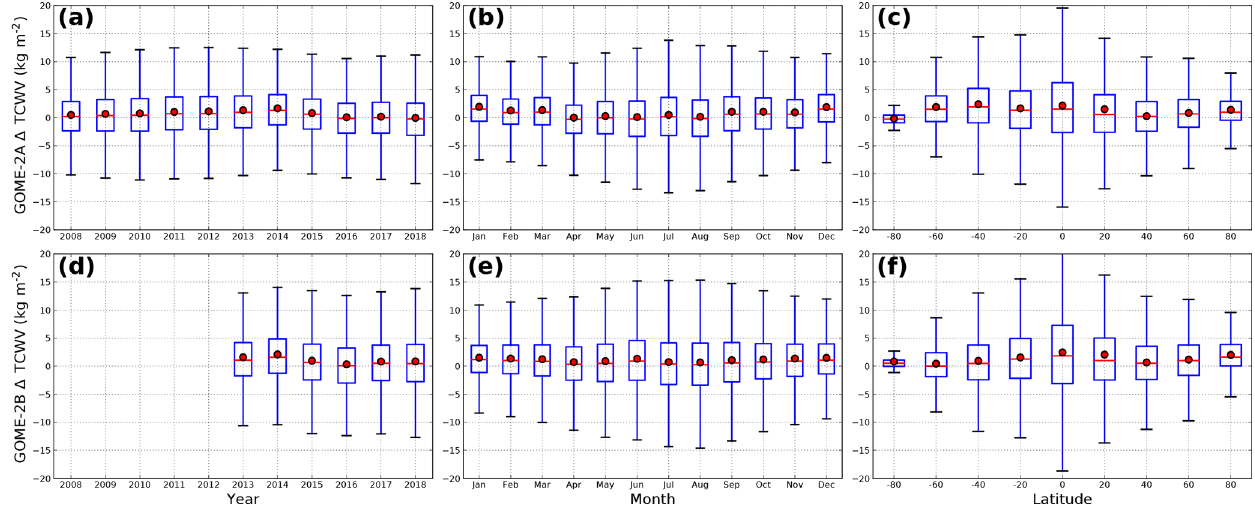
Figure 13. Comparison between sun photometer and GOME-2A observations. Panels (a–c) show GOME-2A data and panels (d–f) show GOME-2B data. Data are sorted by year in (a) and (d) , month in (b) and (e) , and latitude in (c) and (f) .